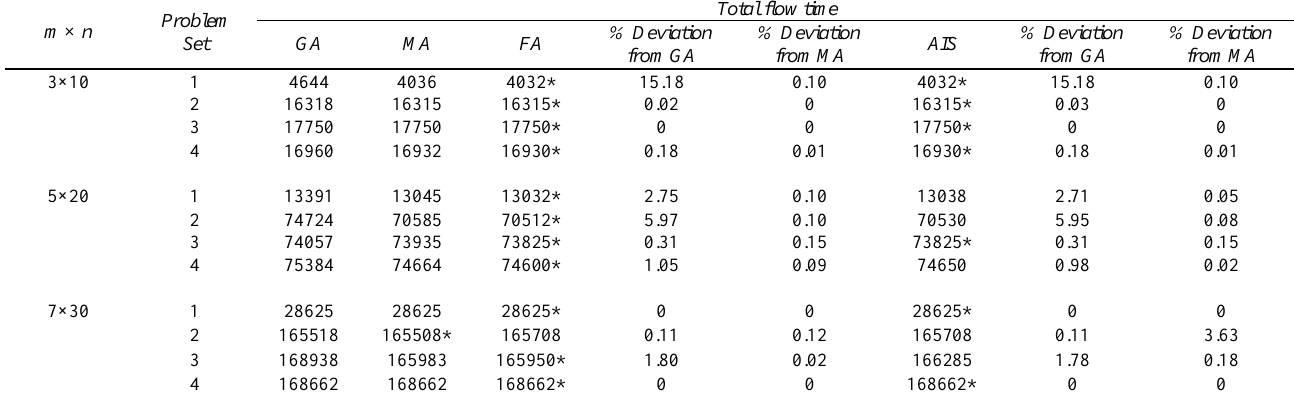
Table 11 – Comparison between FA, AIS, GA and MA for variable size sublots (total flow time)